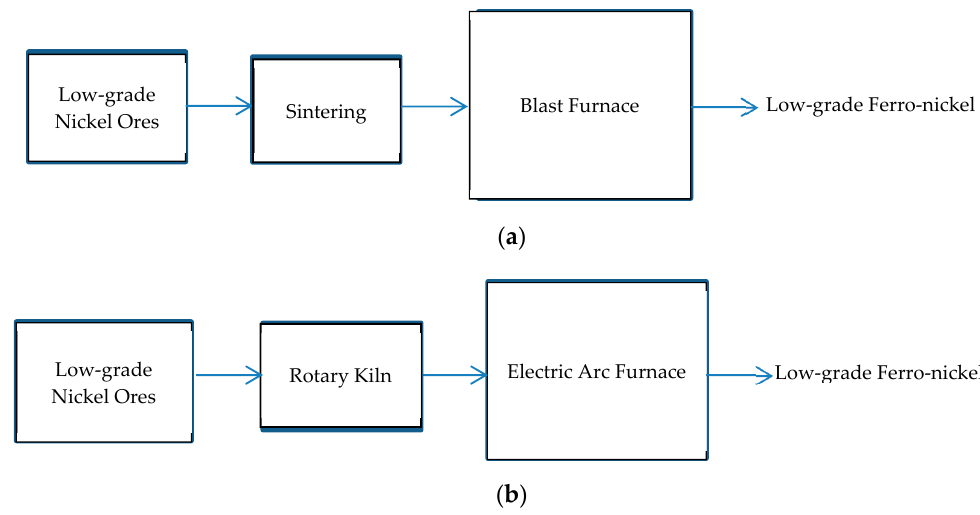
Figure 2. Two main routes of low-grade ferro-nickel production: ( a ) blast furnace and ( b ) rotary kiln – electric arc furnace (RKEF).